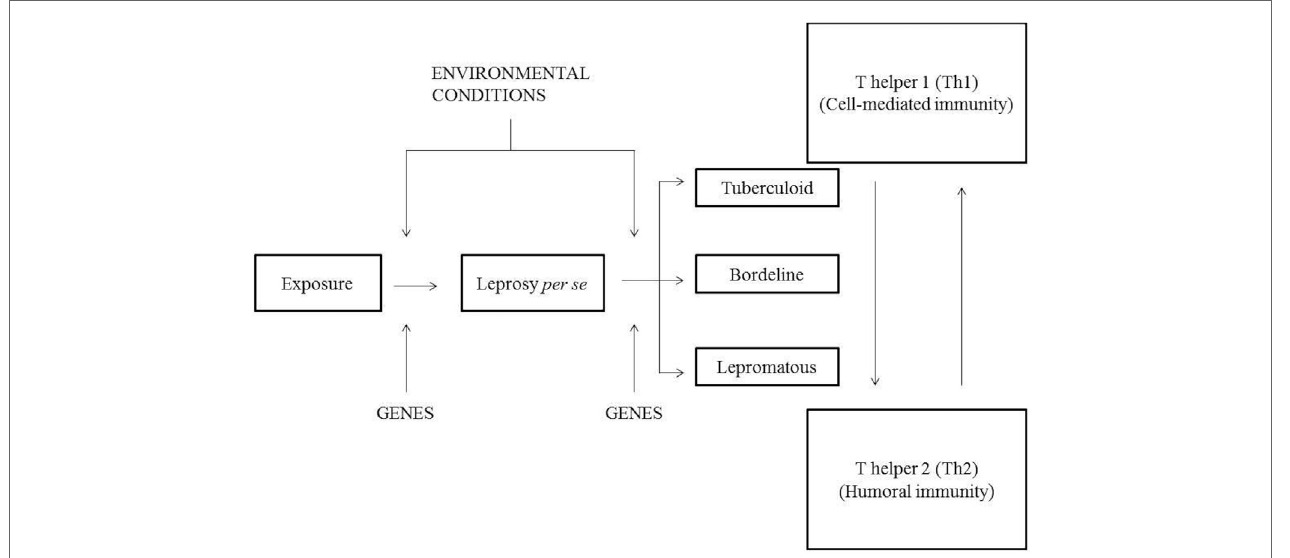
FiGURe 1 | Model of the leprosy spectrum according to Prevedello and Mira